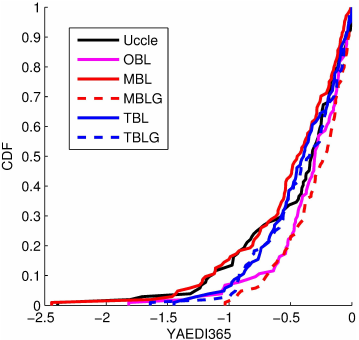
Fig. 4. Empirical cumulative distribution functions for YAEDI 365